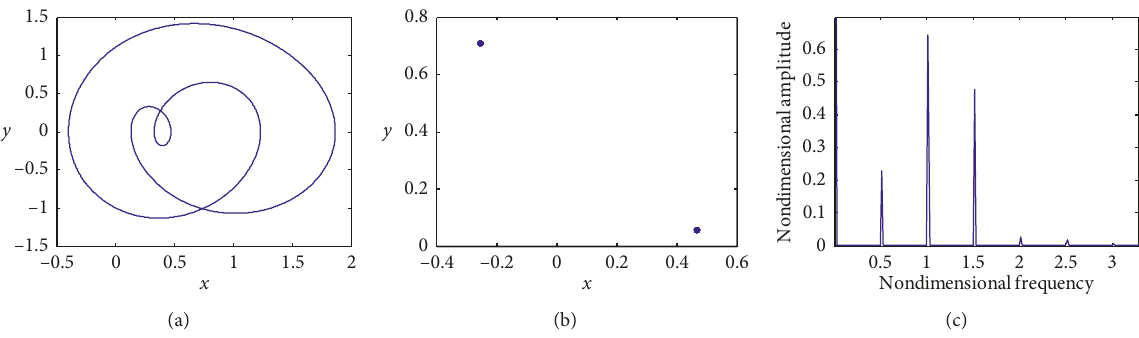
Figure 8: Dynamic response ( f � 0 . 8): (a) phase portrait; (b) Poincar´e map; (c) frequency 2